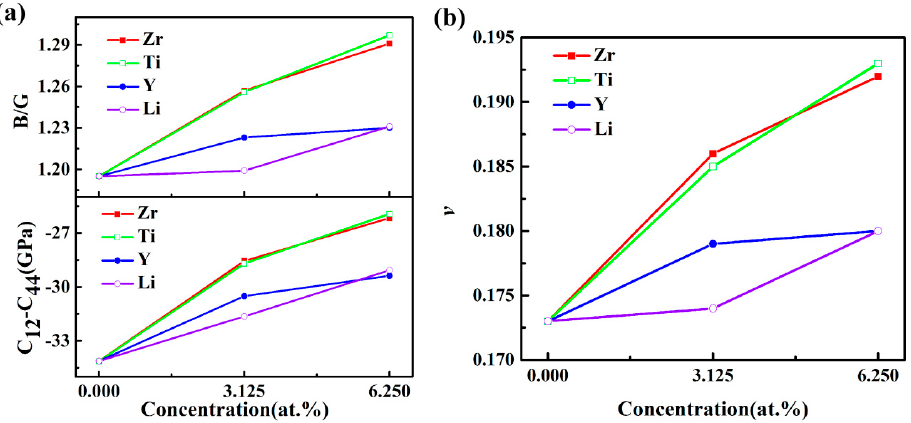
Figure 4. ( a ) B / G and (C 12 – C 44 ) and ( b ) ν of L1 2 -Al 3 Sc doped with element M (M = Zr, Ti, Y, and Li) as a function of the doping concentration.